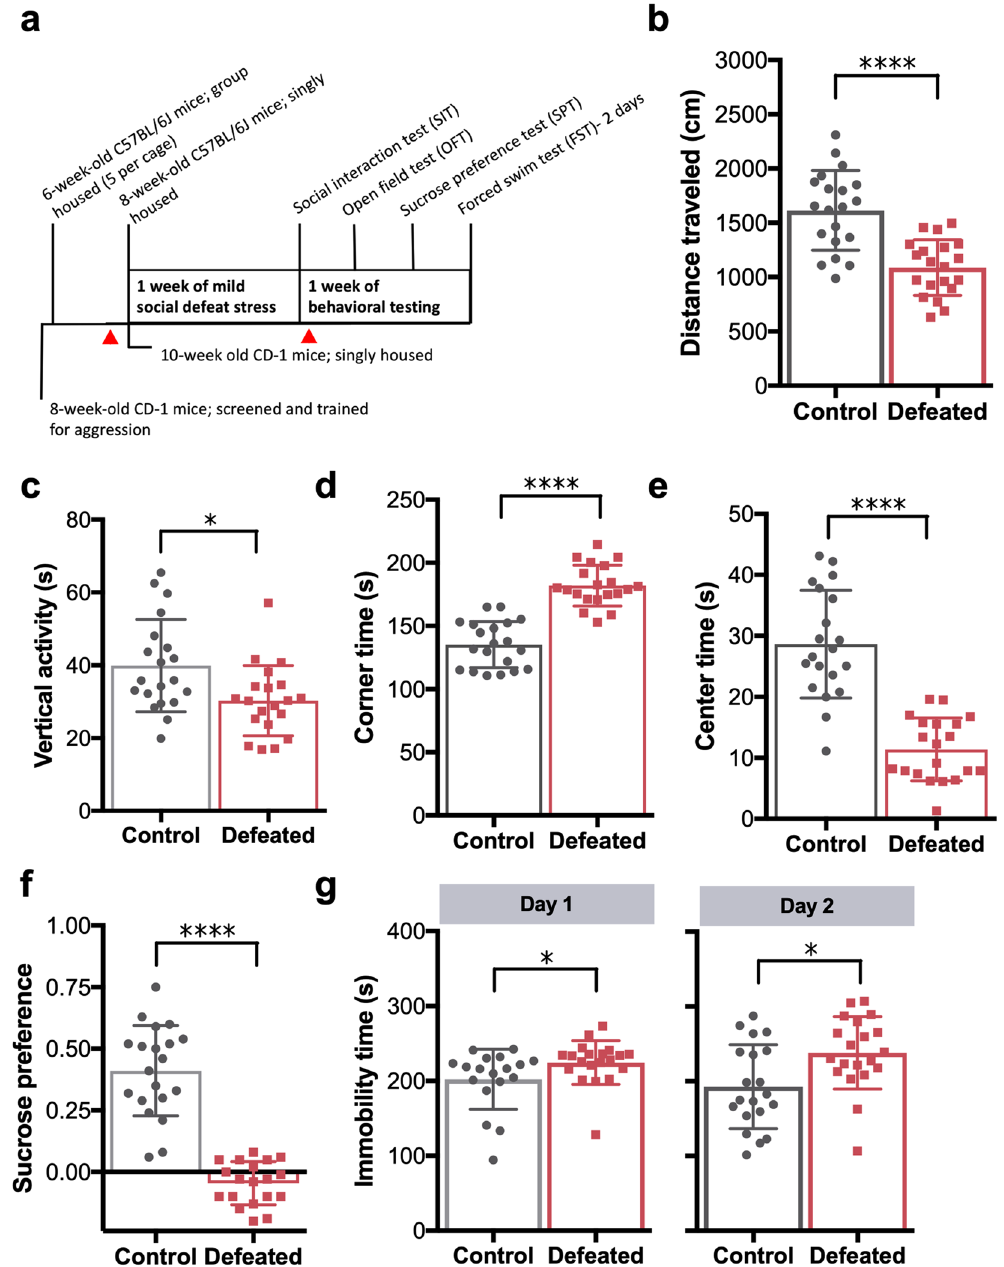
Figure 1. Chronic mild social defeat stress induces anxiety- and depressive-like behavior. ( a ) Experimental design. Red arrows indicate time points of fecal sample collection. ( b – e ) Quantification of behavior during the open field test [n = 20 control and 20 defeated; Wilcoxon rank sum test, * p < 0.05, **** p < 0.0001; mean ± standard deviation (s.d.)]. ( f ) Sucrose preference (n = 20 control and 19 defeated; Wilcoxon rank sum test, **** p < 0.0001; mean ± s.d.). ( g ) Immobility behavior during the two-day forced swim test (day 1: n = 18 control and 20 defeated, day 2: n = 20 control and 20 defeated; Wilcoxon rank sum test, * p < 0.05; mean ±